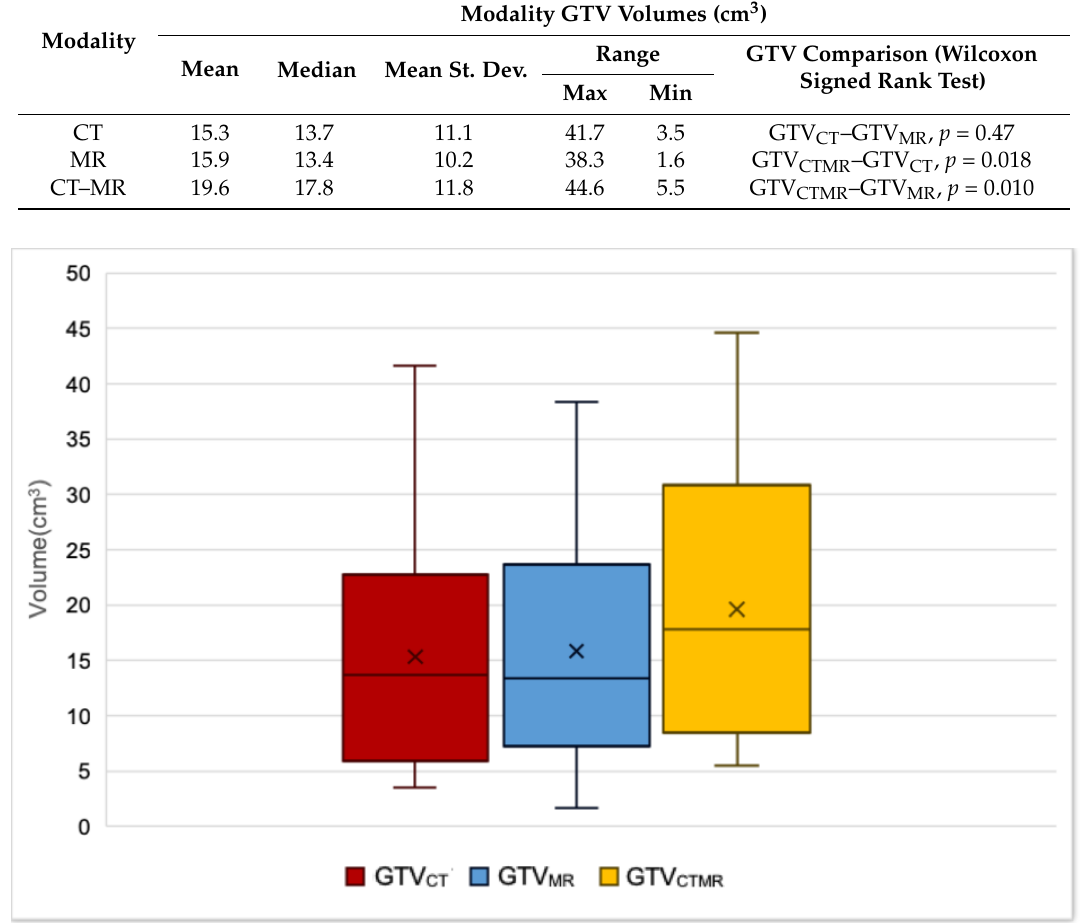
Table 2. Summary of volume of GTVs contoured using CT, MR, and deformably registered MRI to CT. Statistically significant differences in bold ( p < 0.02).